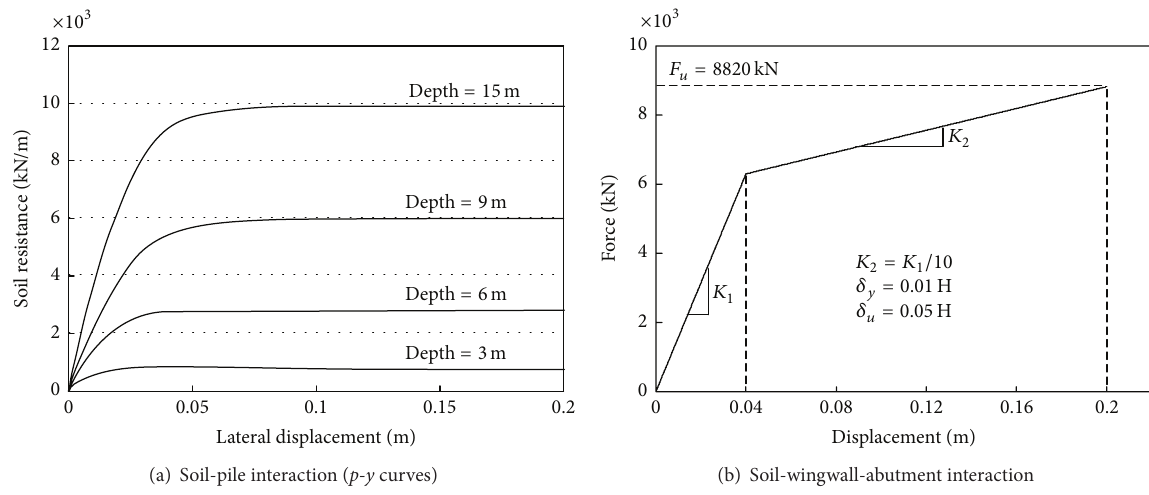
Figure 4: Soil-structure interaction at abutments and foundation of